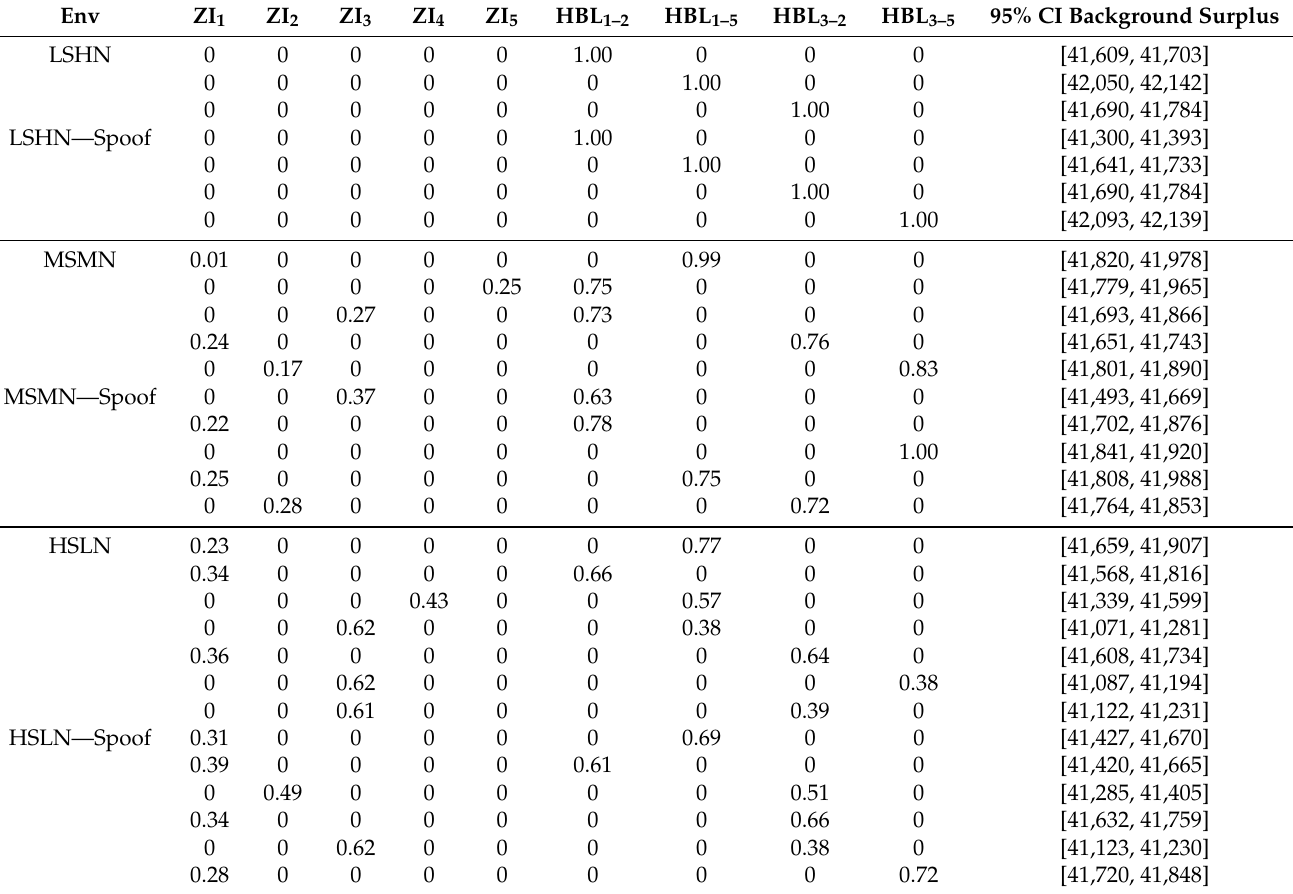
Table A18. Equilibria for games where the learning-based trading strategy set is comprised of standard HBL and HBL with price level blocking. Each row describes an equilibrium found for the game described by the Env column, detailing the adoption rate of each strategy considered and the corresponding background